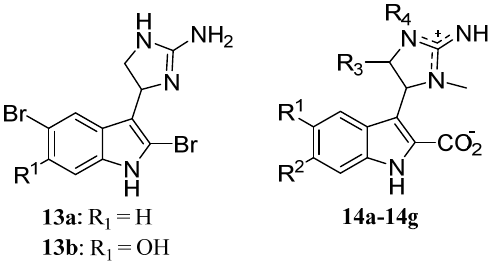
Figure 2. The structure of compounds 13a - 14g .